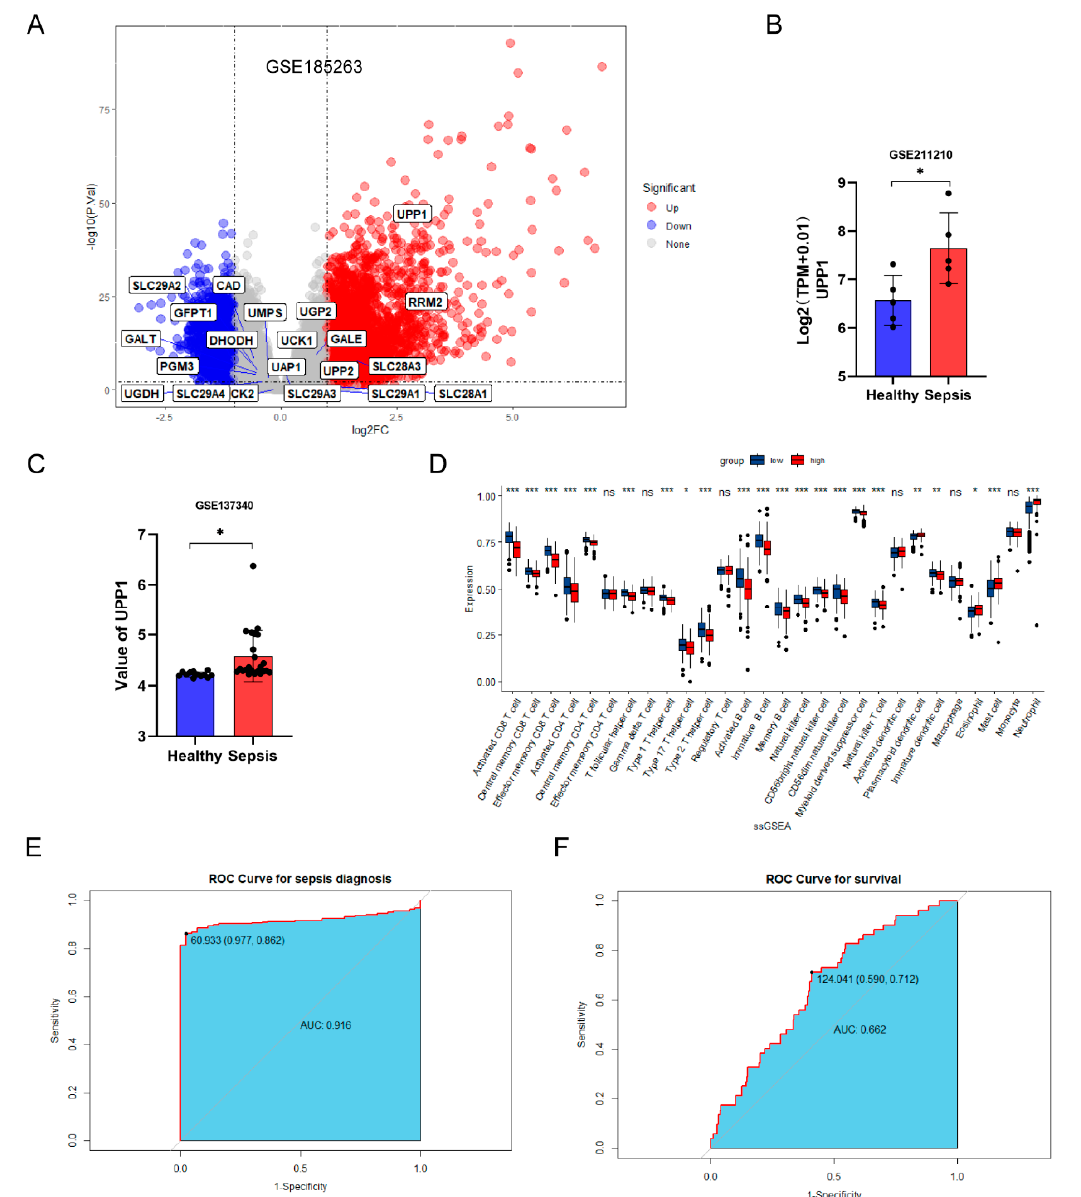
Figure 7. Dysregulated uridine metabolism was confirmed in sepsis patients through meta-GEO datasets. ( A ) The volcano plot for differentially expressed genes in blood samples between sepsis and healthy control in GSE185263. Uridine metabolism-related genes were marked in the plot. ( B , C ) Relative UPP1 expression in GSE211210 and GSE137340, respectively. ( D ) Differential analysis of 28 immune-infiltrating cells according to ssGSEA analysis between UPP1 highly expressed and lowly expressed group in patients with sepsis. ( E , F ) The receiver operating characteristic (ROC) curve for diagnosing sepsis and predicting survival for patients with sepsis, respectively. (* p < 0.05, ** p < 0.01, *** p < 0.001, ns, no